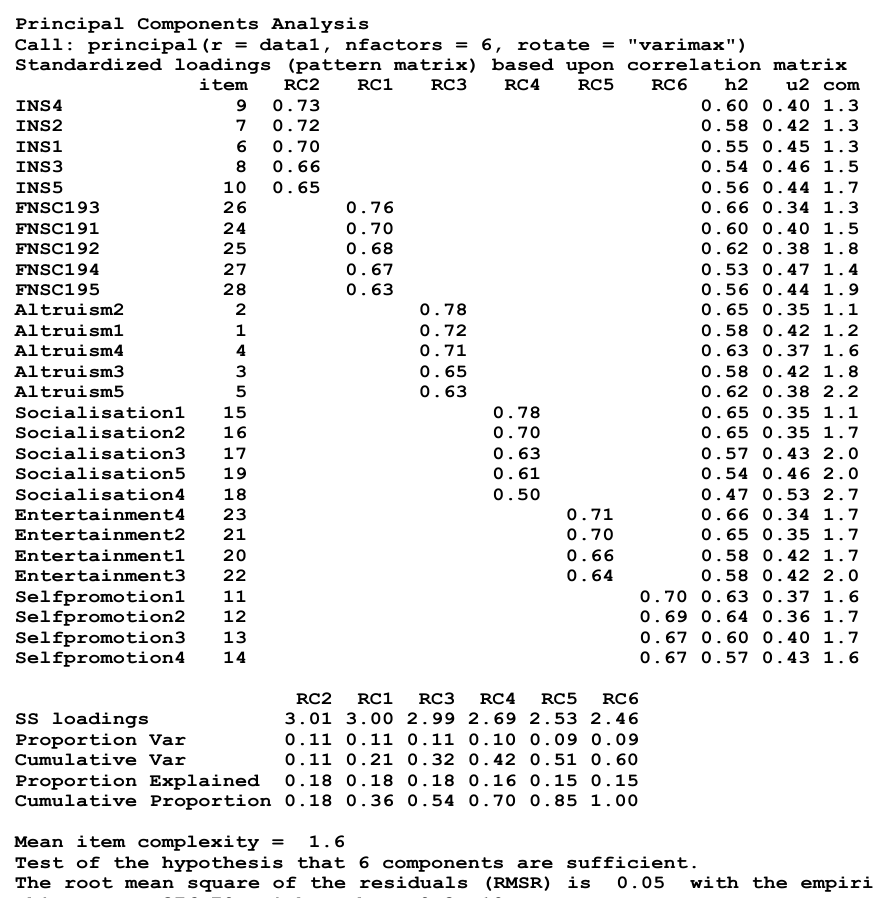
Table 3: Exploratory Factor Analysis (Source: Authors’ calculations)